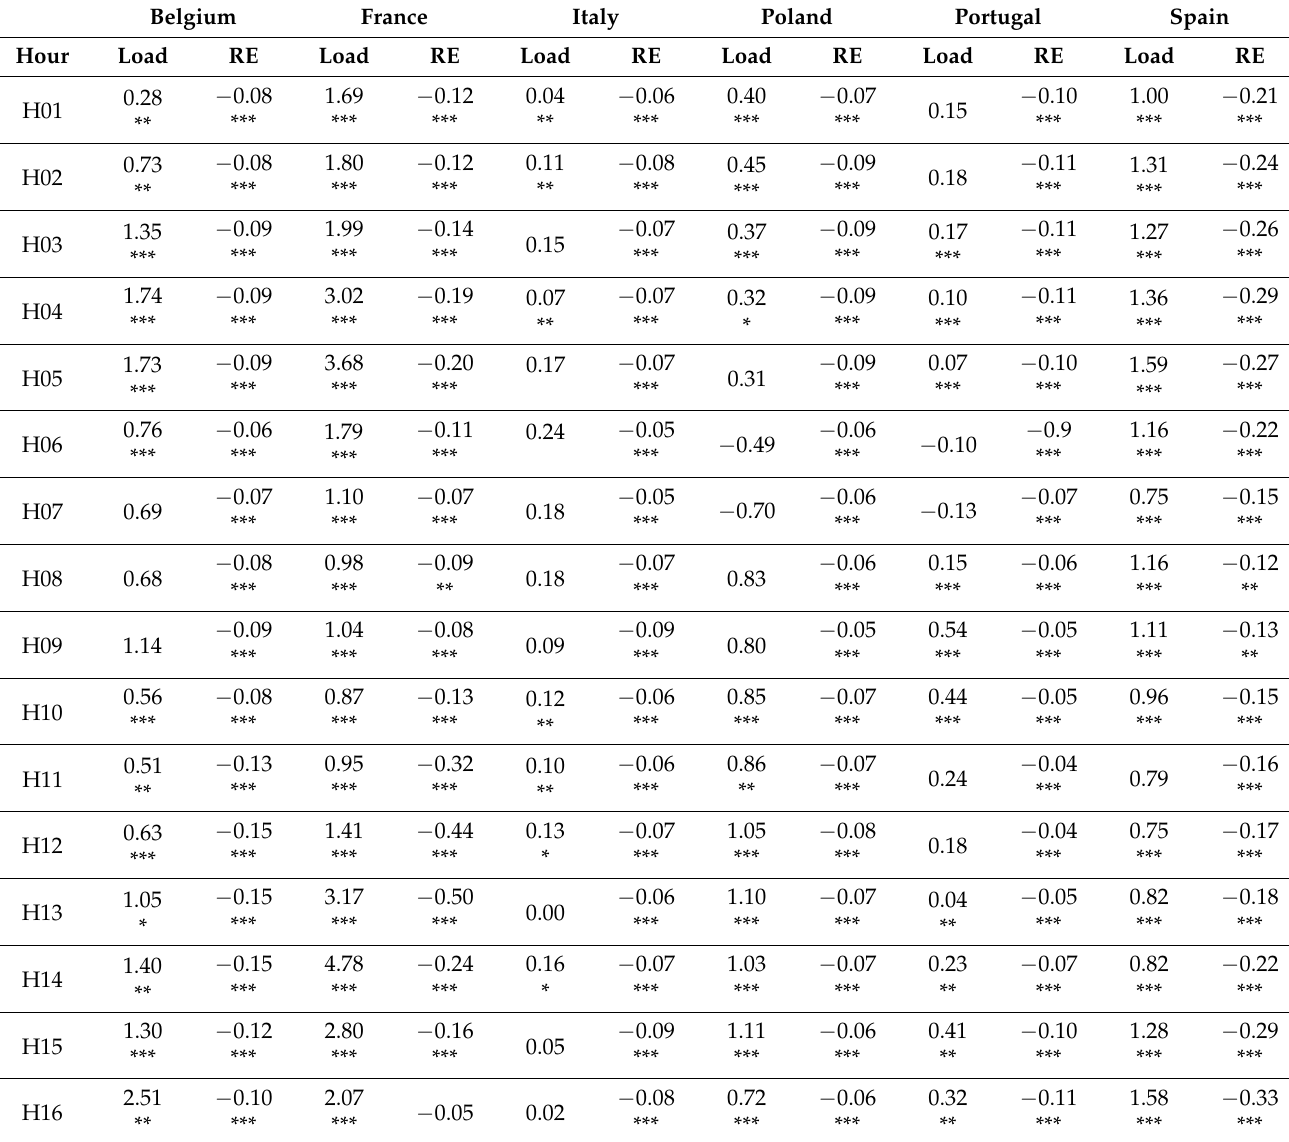
Table 1. Estimation results for the slope coefficients of panel